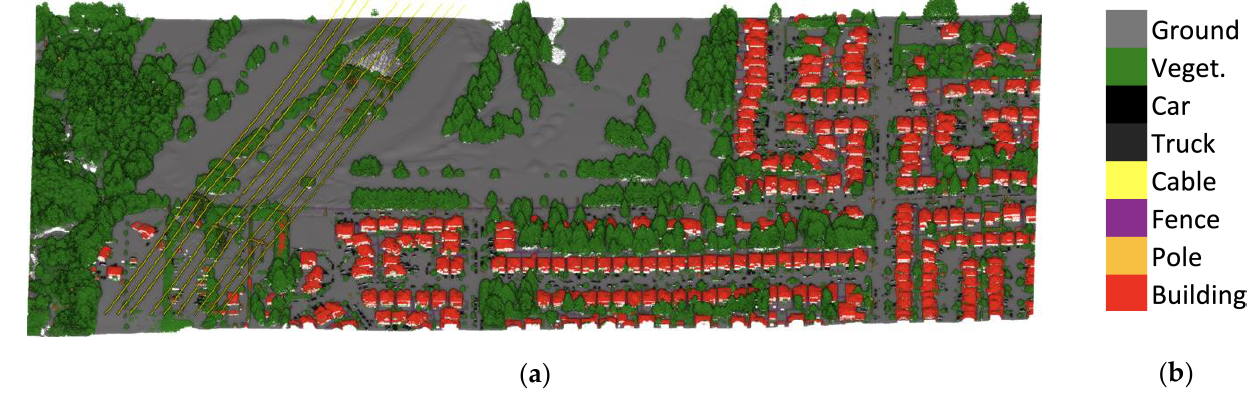
Remote Sens. 2021 , 13 , x FOR PEER REVIEW